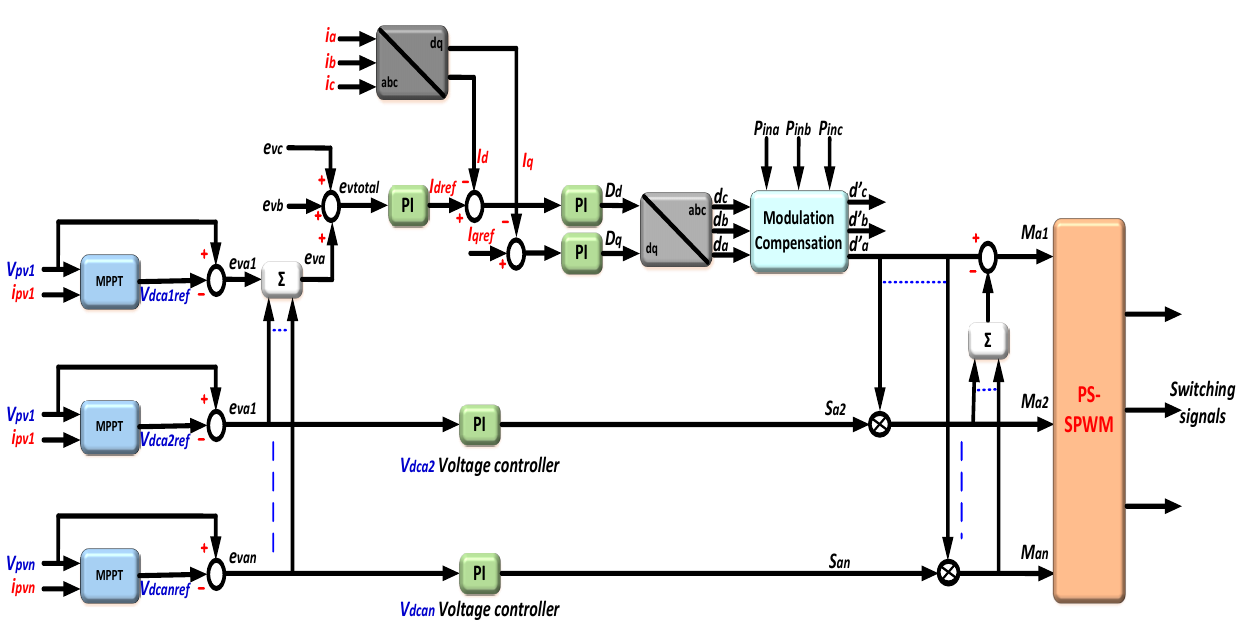
Figure 20. The control scheme for 3-ph cascaded H-bridge multilevel inverter for PV [163].